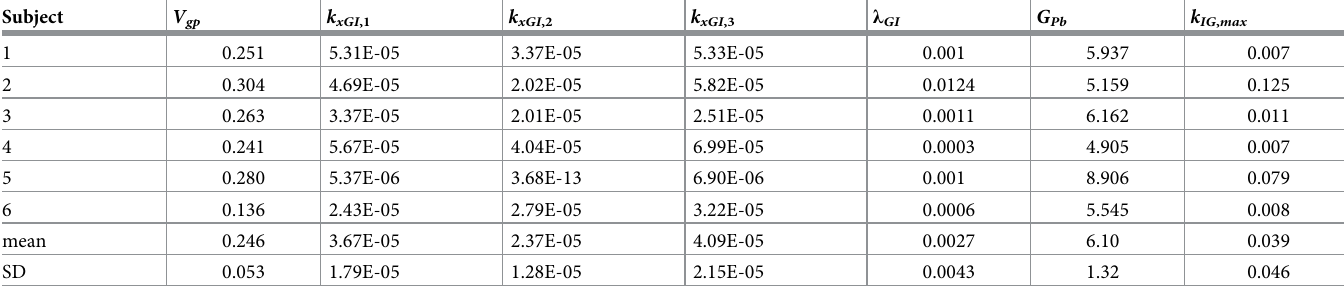
Table 6. Parameter estimates of the one-glucose compartment model with autocorrelated